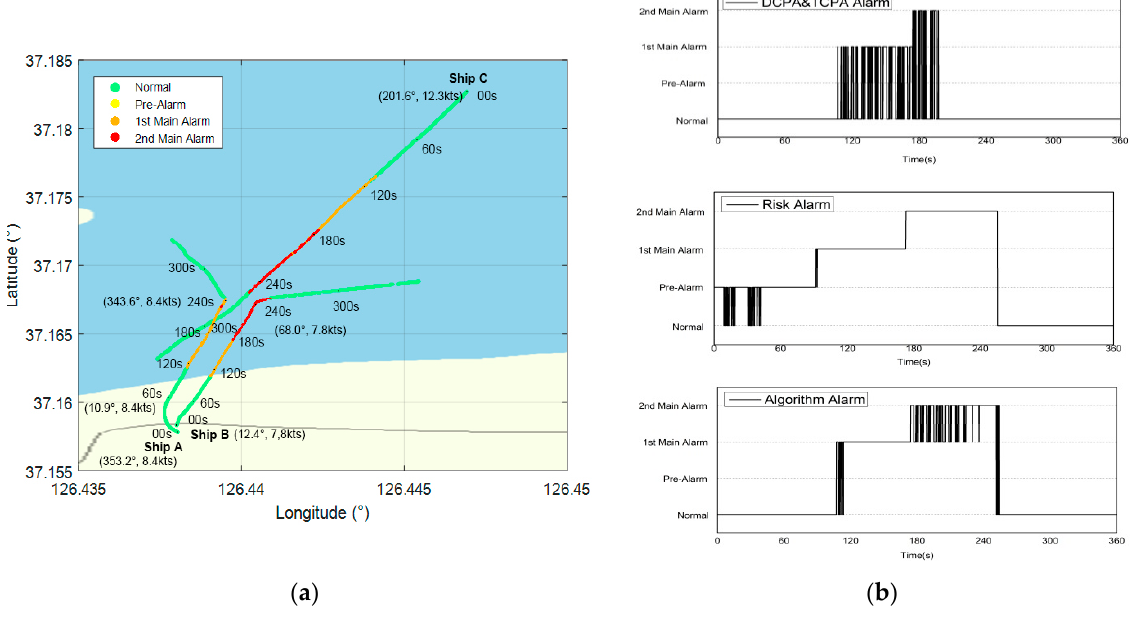
Figure 5. ( a ) Diagrammatic representation of the track of alarms generated from the test results of Scenario 1 and ( b ) graphical representation of the alarms generated on ship C depending on time (from the top, alarms based only on the DCPA and TCPA criteria, alarms based only on PARK model risk value criterion, and alarms based on the algorithm).